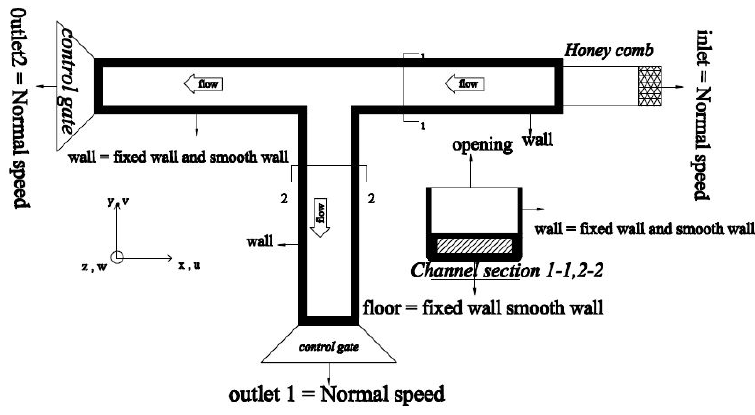
Figure 4. Boundary condition of the simulated model using the ANSYS-CFX.